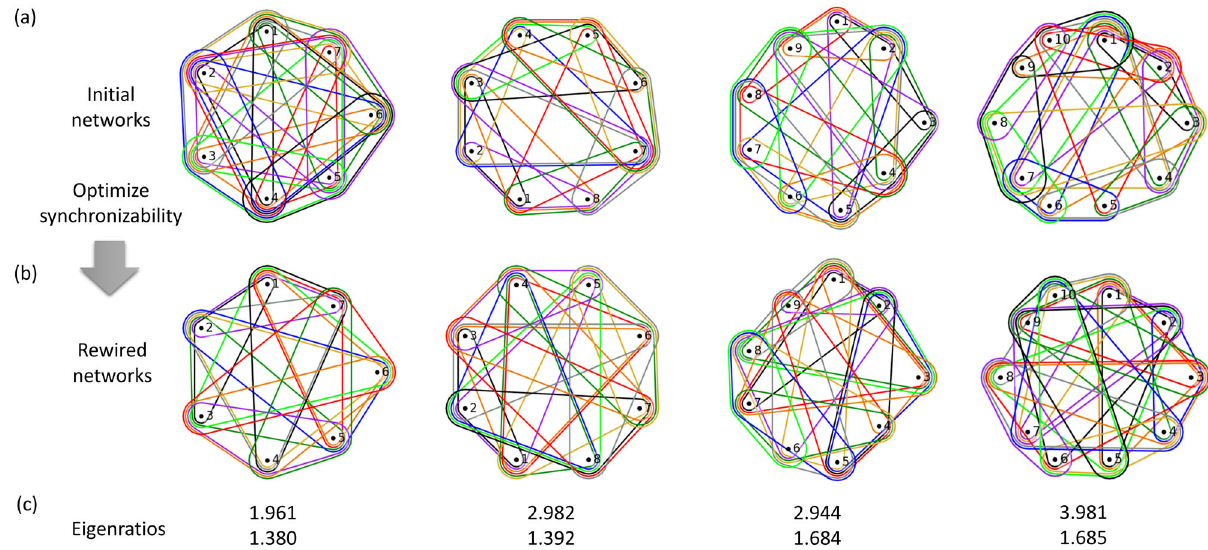
Fig. 2 Examples of the network with 2-hyperlink interactions before and after the optimization on synchronizability. The colored triangles denote various 2-hyperlink interactions with different colors for better visualization. a The initial networks before the optimization. b The rewired network after the optimization. We show the networks with small sizes, N = 7, 8, 9, 10, for better visualization on the 2-hyperlink interactions. c The eigenratios before and after the